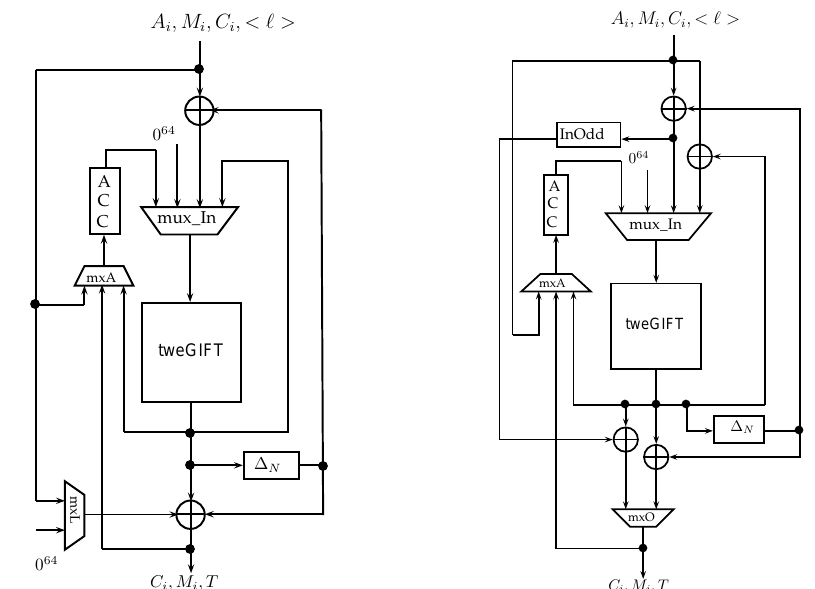
Figure 5: Hardware Architectures of LOCUS (left) and LOTUS